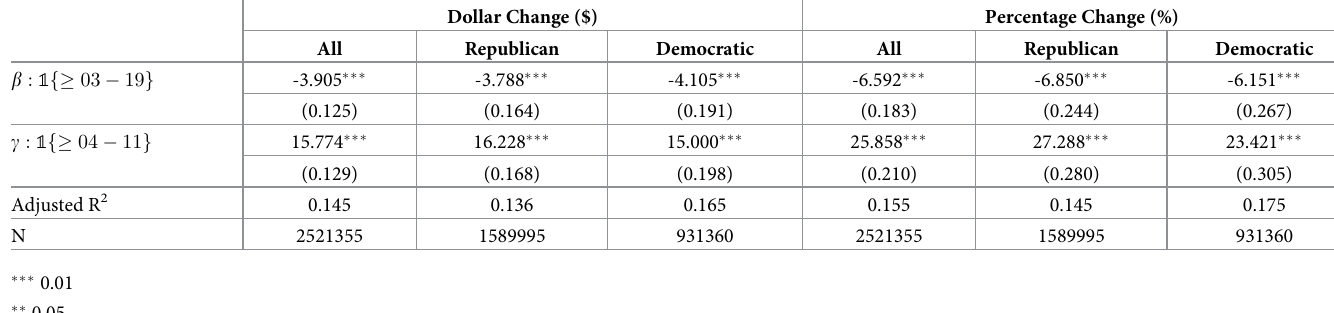
Table 2. Effects of initial lockdown and stimulus payments on per card